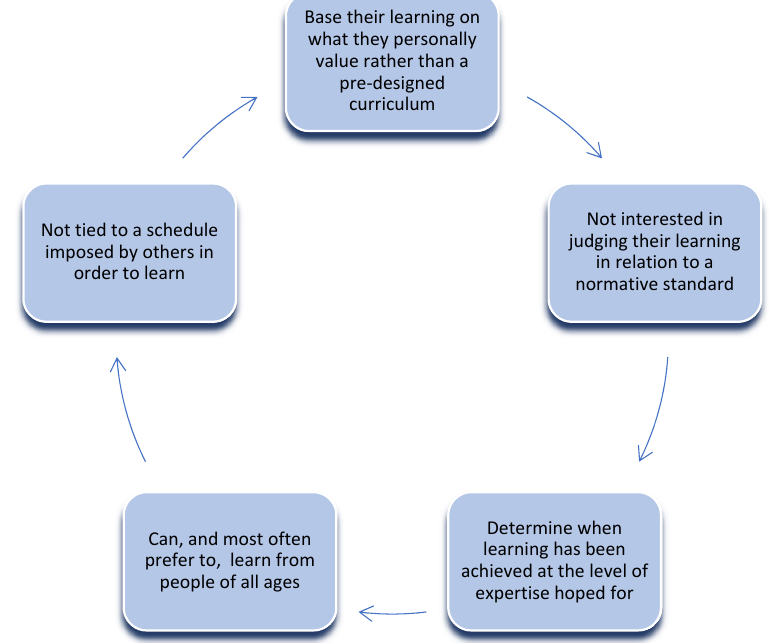
Figure 1. What distinguishes a self-directed learner?